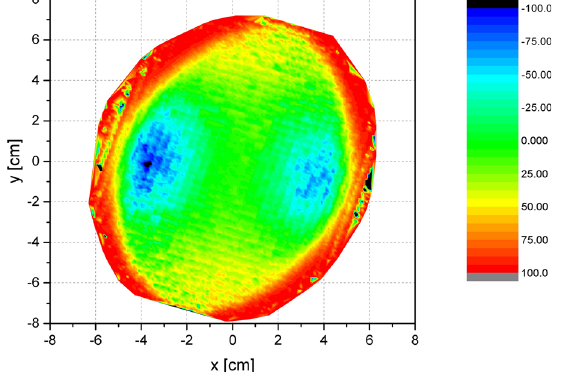
FIG. 8. Difference in the proton fluence in % between the measured (using the built-in fixed source option in MCNPX) and simulated (coupled TURTLE-MCNPX approach) proton beam profile.